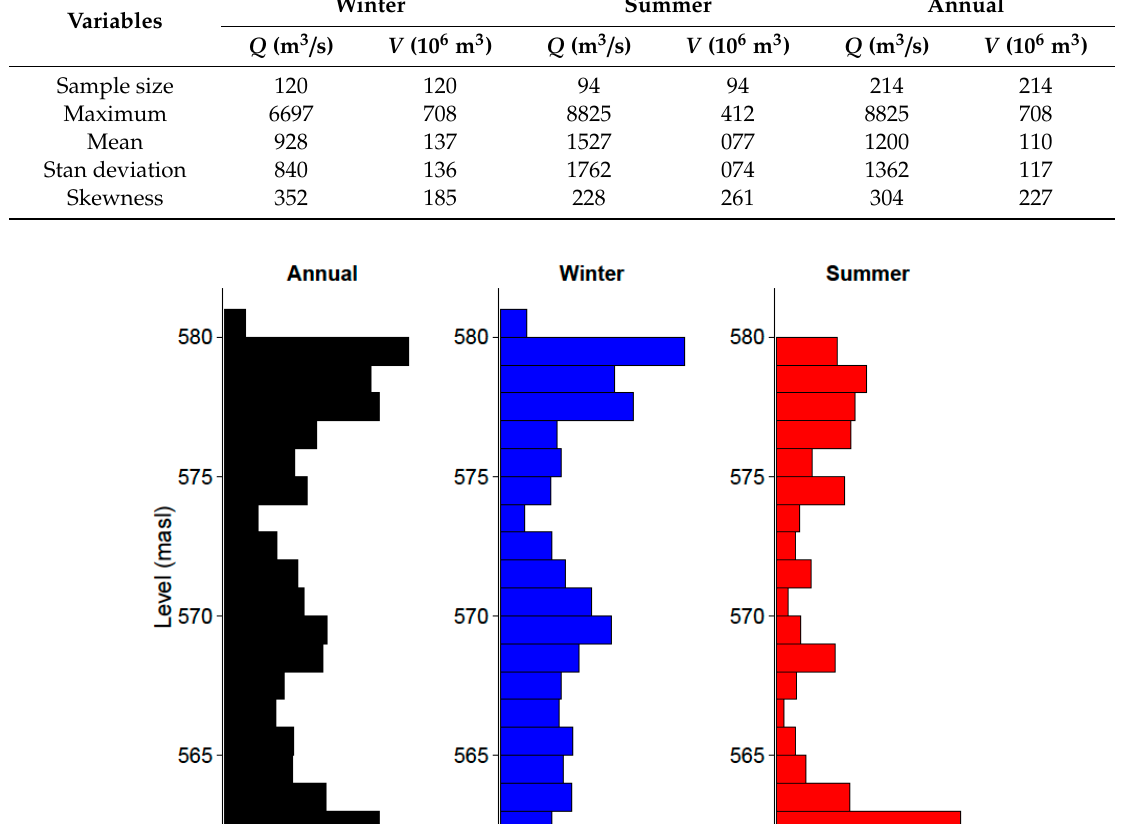
Table 5. Probability-weighted moments (PWM) estimated parameters.